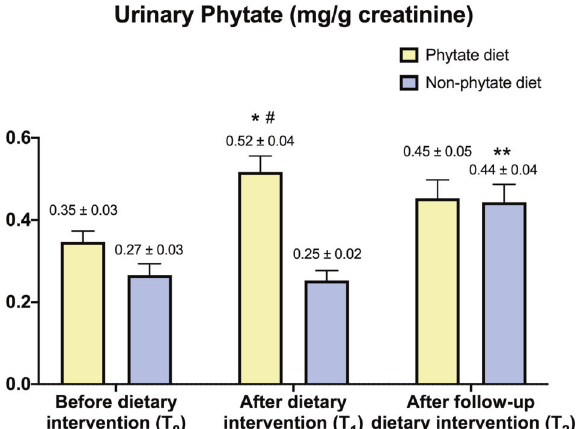
Fig. 3 Effect of phytate diet on urinary levels of InsPs. Values are expressed as means and SEM. Intragroup differences (T0 vs. T1, T1 vs. T2) were assessed using a paired-sample Wilcoxon signed-rank test (* P value <0.05 for T0 vs. T1, ** P value for T2 vs. T1 & T2 vs.T0). Intergroup differences (phytate diet vs. non-phytate diet) were assessed using Mann – Whitney U test for the before-dietary intervention group, and analysis of covariance after adjusting for baseline levels (#). Benjamini – Hochberg procedure was used to correct for the false discovery